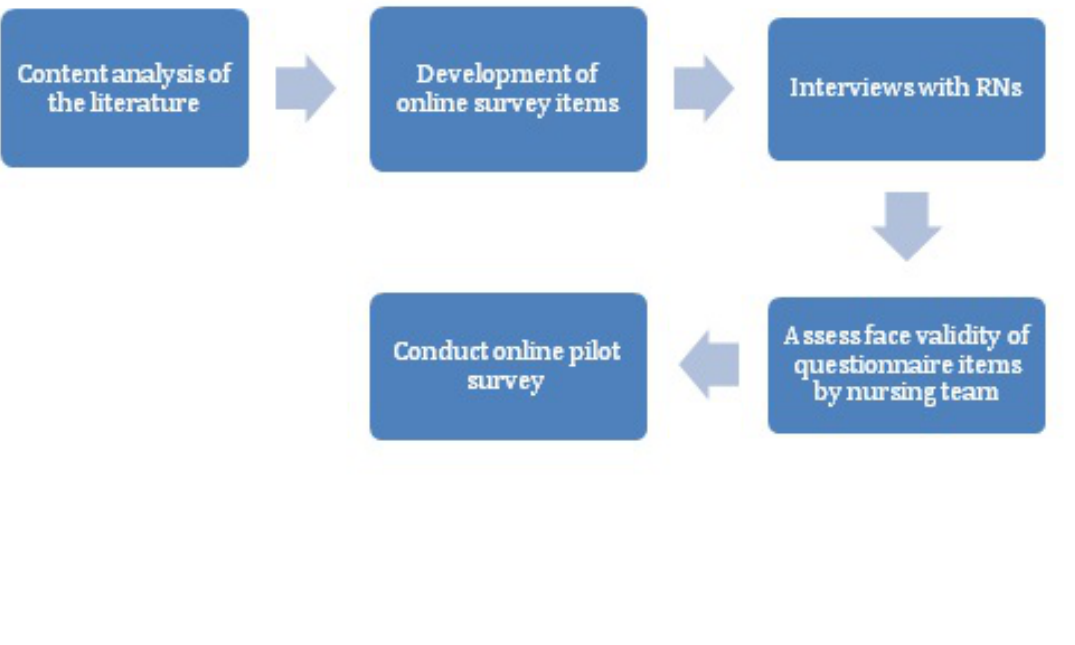
Figure 1. The validation process for the development of the online